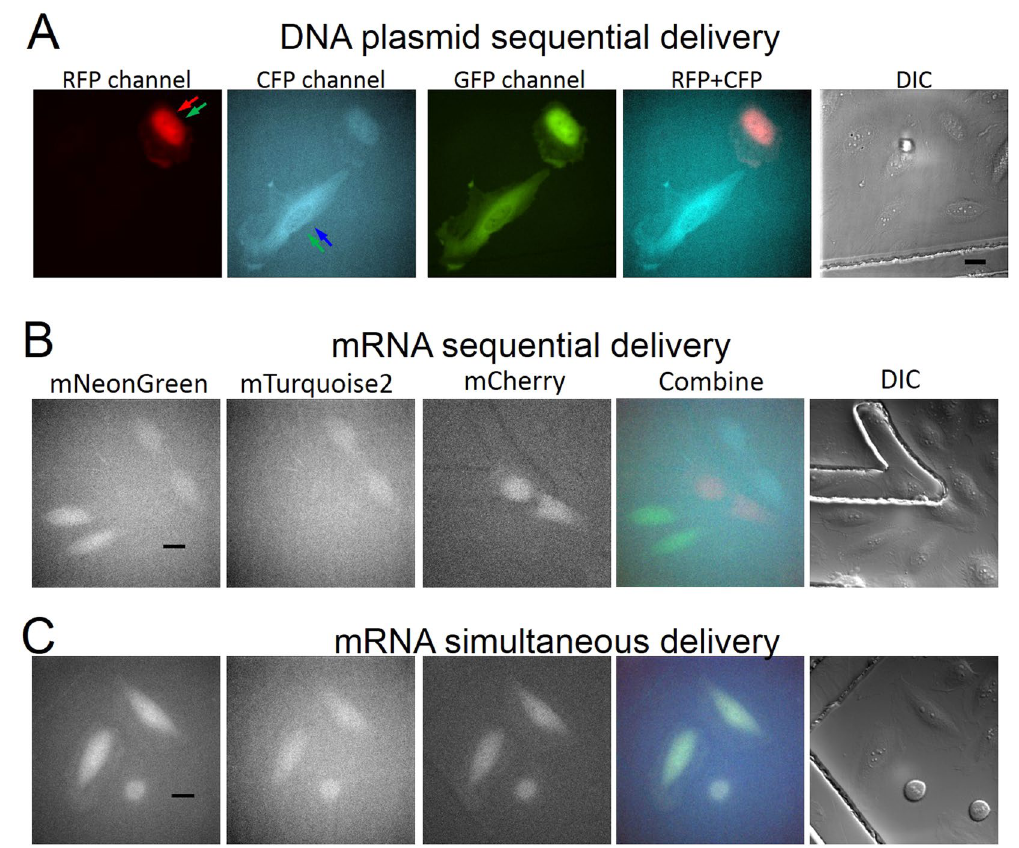
Figure 3. Sequential and simultaneous single-cell intracellular delivery of DNA plasmids and mRNA into adjacent cells. The Vp and tw of each electrical pulse was 22 V and 18 μ s, respectively, and NP = 1 unless otherwise indicated. ( A ) Green and red arrows in the first panel and blue and green arrows in the second panel indicate that the cells were acoustic-transfected with FRET-BS-GreenRed and FRET-BS-CyanYPET, respectively. Images obtained by RFP (first panel) and CFP (second panel) channels show two adjacent cells with RFP and ECFP fluorescence by FRET-BS-GreenRed and FRET-BS-CyanYPET plasmids. ( B ) The mRNA strands expressing mNeonGreen (mNG), mTurquoise2 (mTQ2), and mCherry (mCR) were sequentially transfected into individual neighboring cells. Images from left to right were obtained by GFP, CFP, and RFP channels after 20 hours of acoustic-transfection of three types of mRNA. Fluorescence images of the same cells after 40 hours are also available, as shown in Supplementary Fig. 6A. ( C ) Simultaneous delivery of the mNG, mTQ2, and mCR mRNAs was also successfully demonstrated. Three adjacent cells were targeted and three cells functioned normally, thereby indicating the low cytotoxicity of acoustic-transfection. Scale bars indicate 20 μ